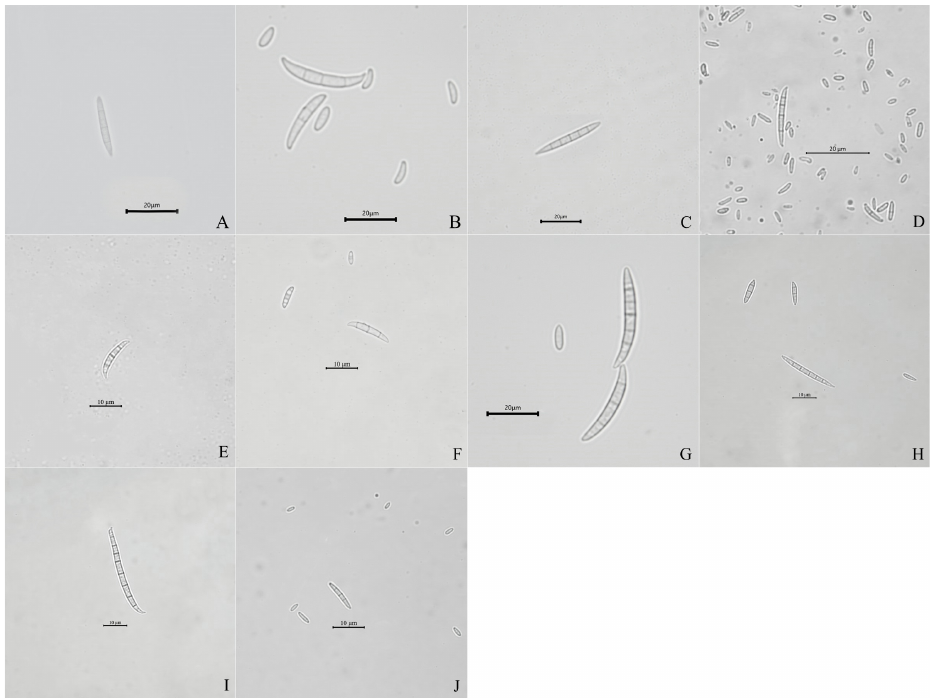
Figure 3. Conidia morphology of representative isolates of 10 Fusarium species. ( A – J ) Macroconidia or microconidia of representative isolates of F. verticillioides , F. subglutinans , Fusarium incarnatum - equiseti species complex, F. temperatum , F. acuminatum , F. solani , F. sporotrichioides , F. tricinctum , F. asiaticum , and F. proliferatum , respectively.